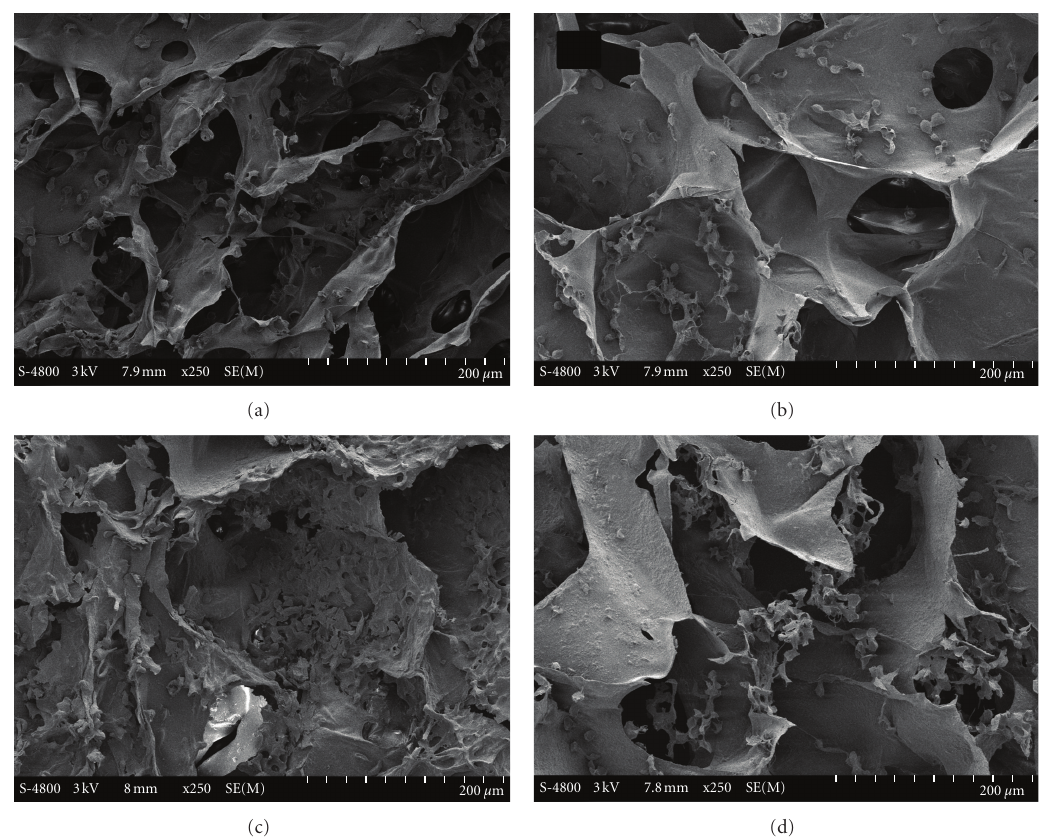
Figure 5: Cross-sectional SEM images of L929 fibroblast cells cultured in the sca ff olds. (a) Col: NP = 6:0; (b) Col:NP = 6:1; (c) Col:NP = 6:3; (d) Col:NP = 6:6